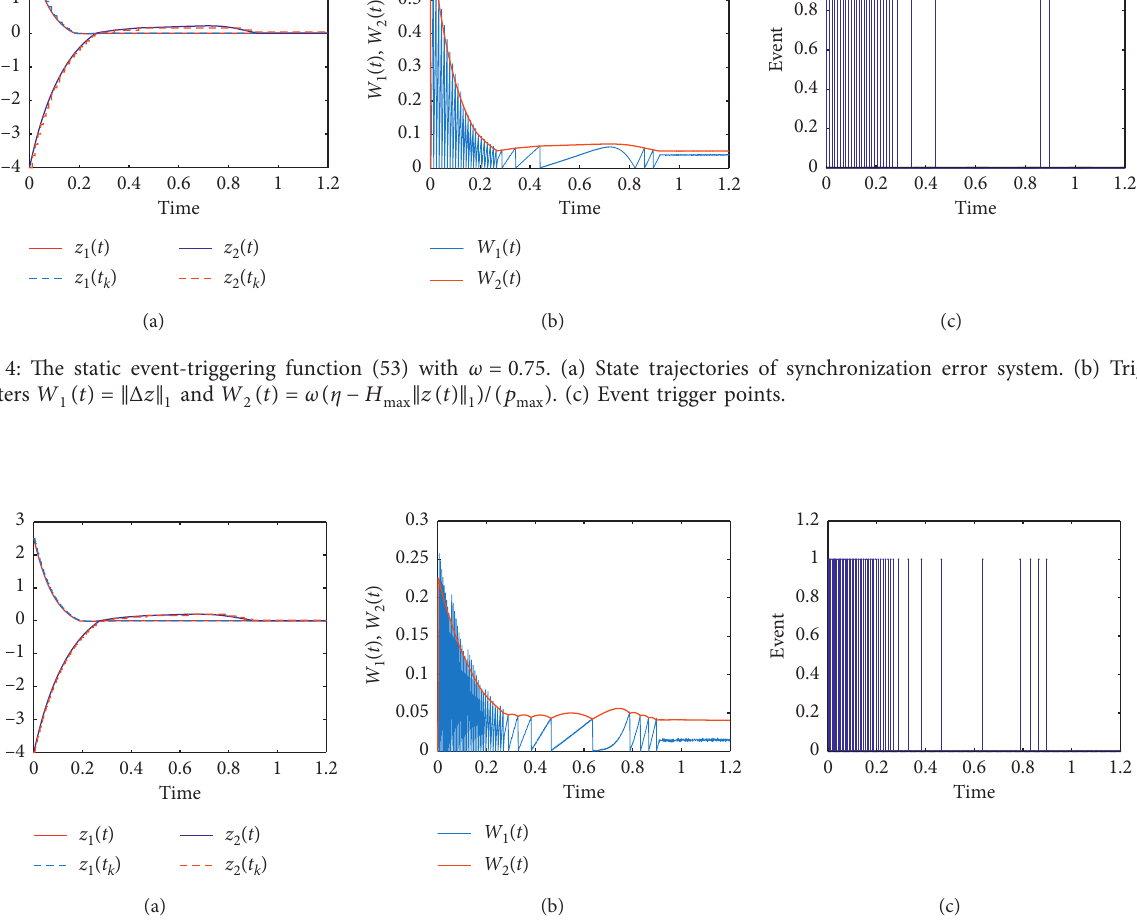
‖ z ( t )‖ ) / ( p ) . (c) Event trigger points. max 1 max